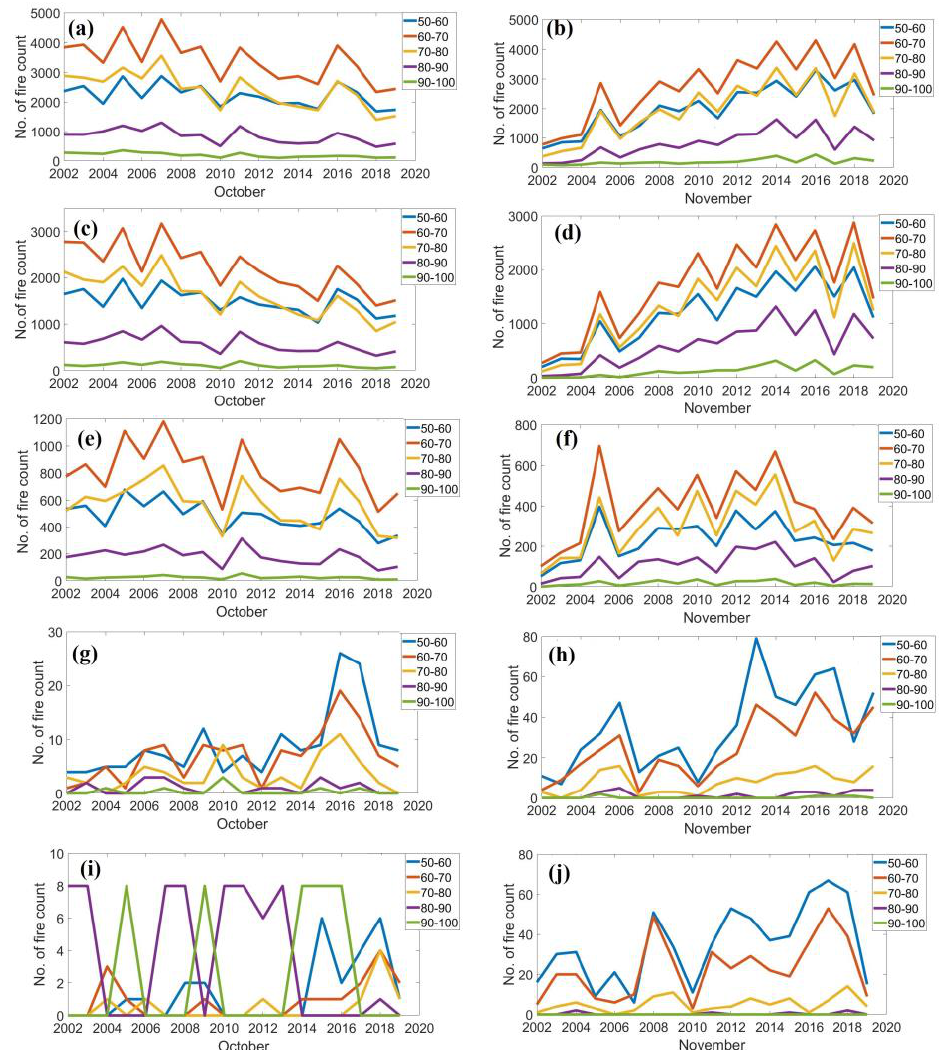
Figure 4. Time series of the number of fire counts in the different fire confidence range in the month of October ( a ) and November ( b ) over the Indian region (20 – 40° N and 60 – 90° E). Similarly, ( c , d ) Northwestern region (70° E – 76° E, 29° N – 32° N), ( e , f ) Delhi region (76° E – 78° E, 27° N – 31° N), ( g , h ) Lucknow (78° E – 81.5° E, 26° N – 28N) and ( i , j ) Patna region (82° E – 85° E, 25° N – 27° N)